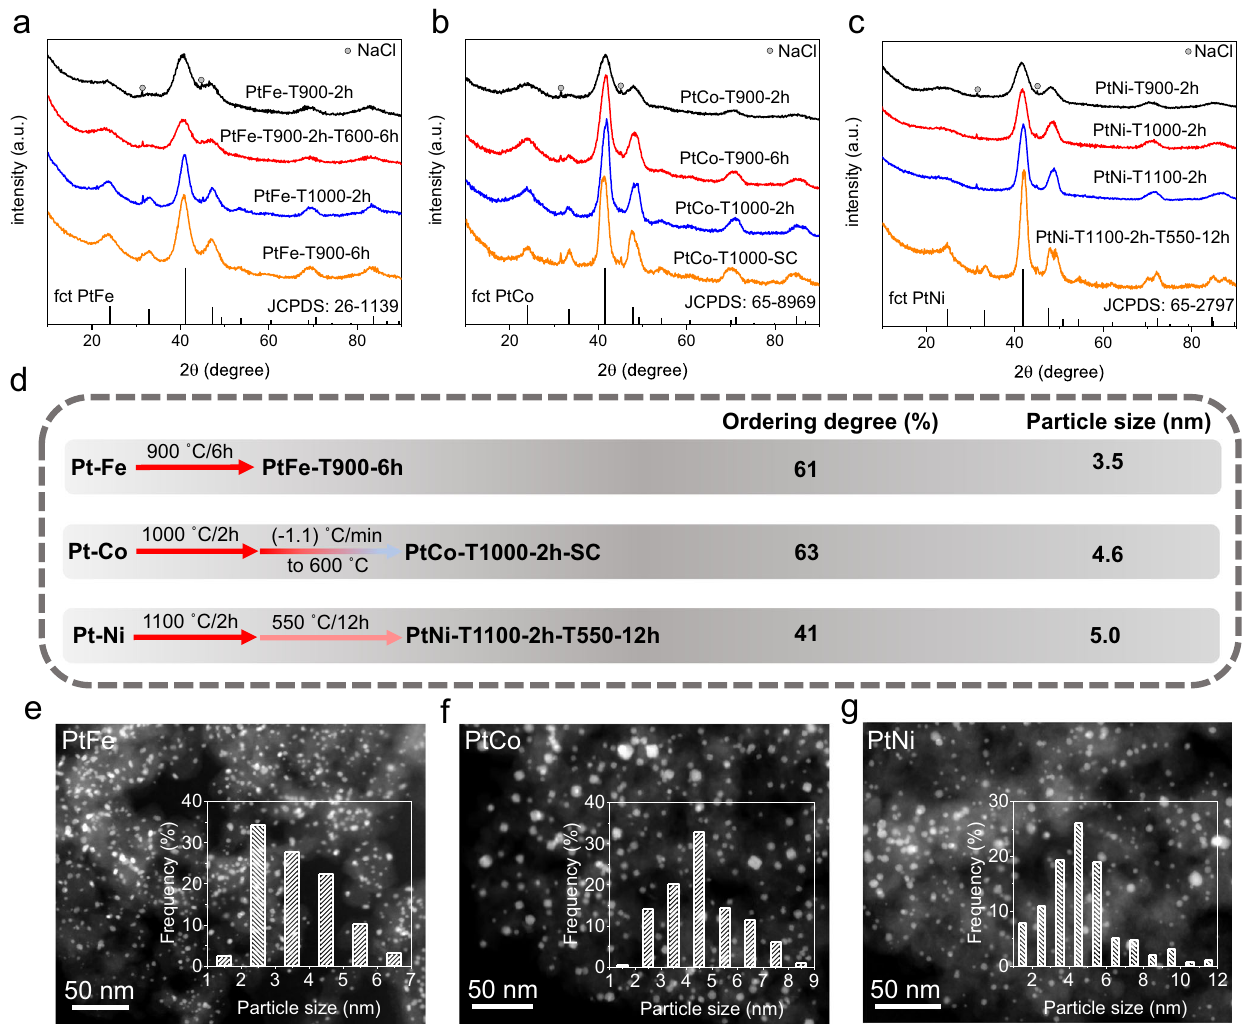
Fig. 3 | Synthesis and structural characterization results. a – c X-ray diffraction (XRD)patternsofthePt – Fe,Pt – Co,andPt – Nicatalysts,respectively. d Summaryof theannealingprotocols,orderingdegrees,andaverageparticlesizesofPtFe-T900- 6h, PtCo-T1000-2h-SC, and PtNi-T1100-2h-T550-12h. e – g High-angular annular